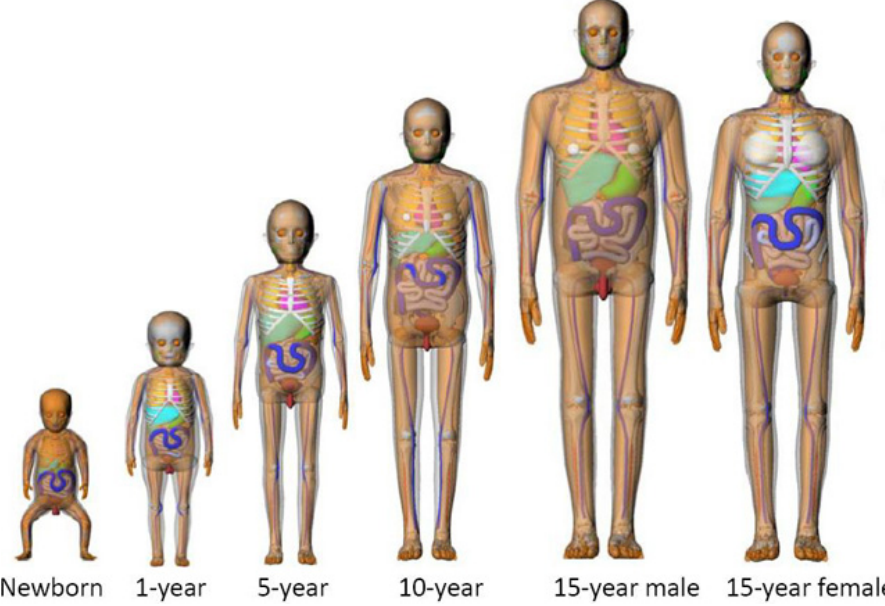
Figure 4. Family of hybrid phantoms